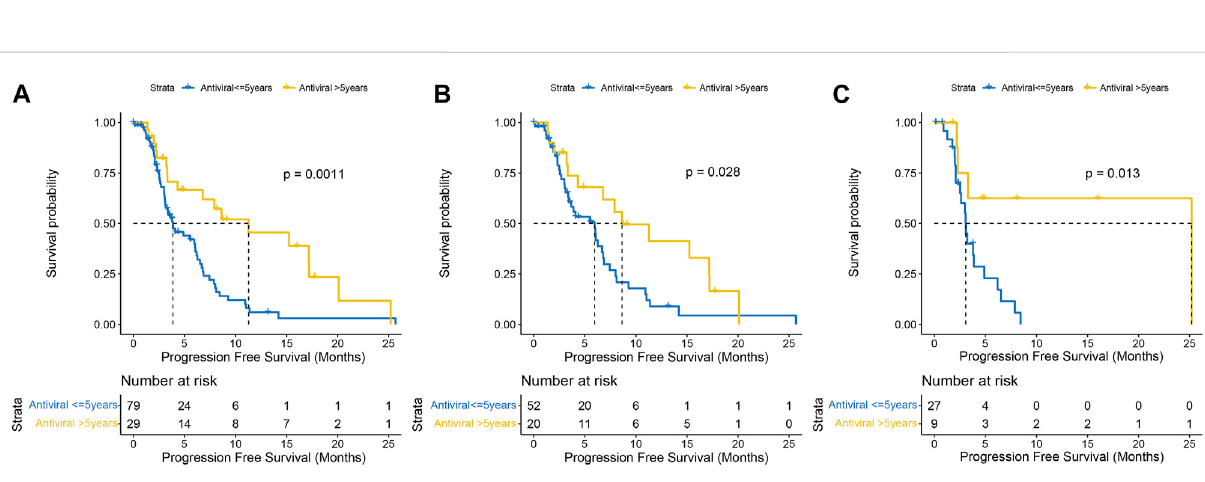
FIGURE 3 Kaplan-Meiercurves ofprogression-freesurvivalwith antiviral therapy earlierthan 5 years versus lessthan5 yearsinthewholepopulation (A) HBV-HCC (B) and HCV-HCC (C)